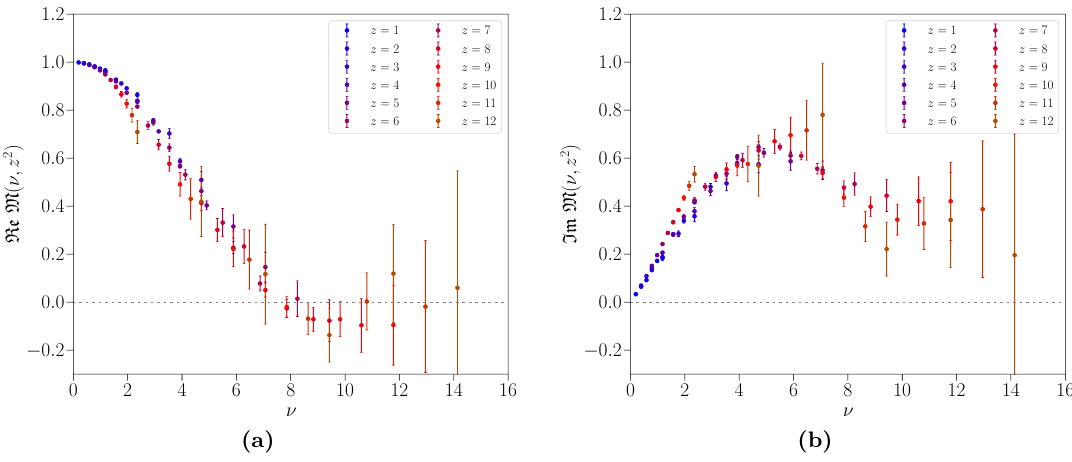
Figure 4. (a) Real and (b) imaginary component of the unpolarized reduced pseudo-ITD on the a 094 m 358 ensemble with Wilson line extents z/a < 13